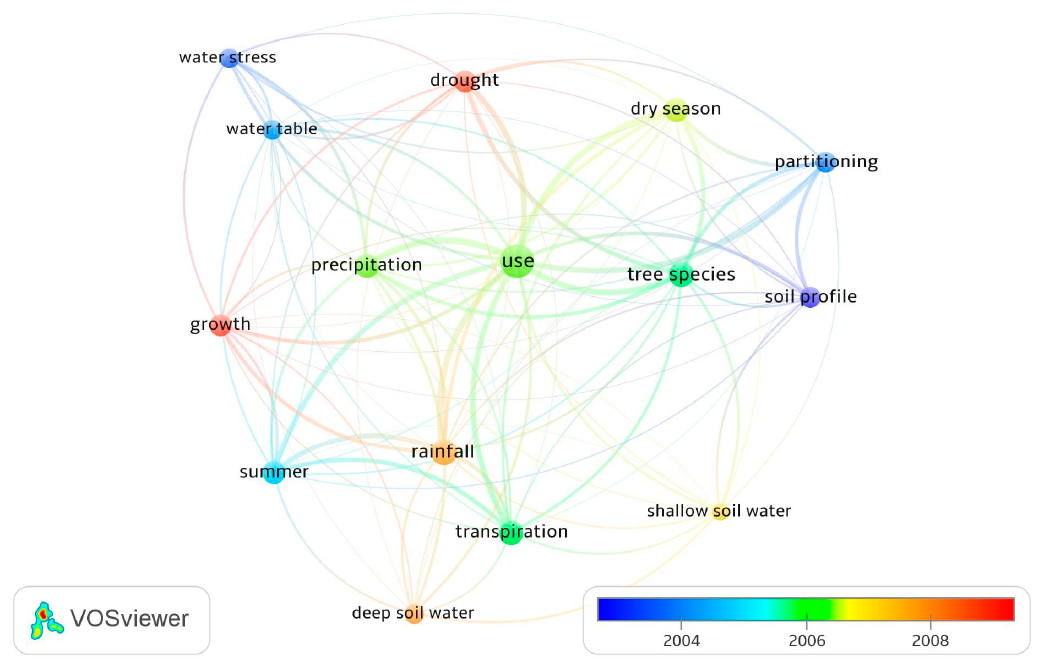
Figure 4. The terms most frequently cited in the abstracts of reviewed articles. Note: Each term was cited at least 10 times; Colors are based on the years for which the terms were most frequently cited; the distance between two nodes indicates the degree of relatedness between the terms.